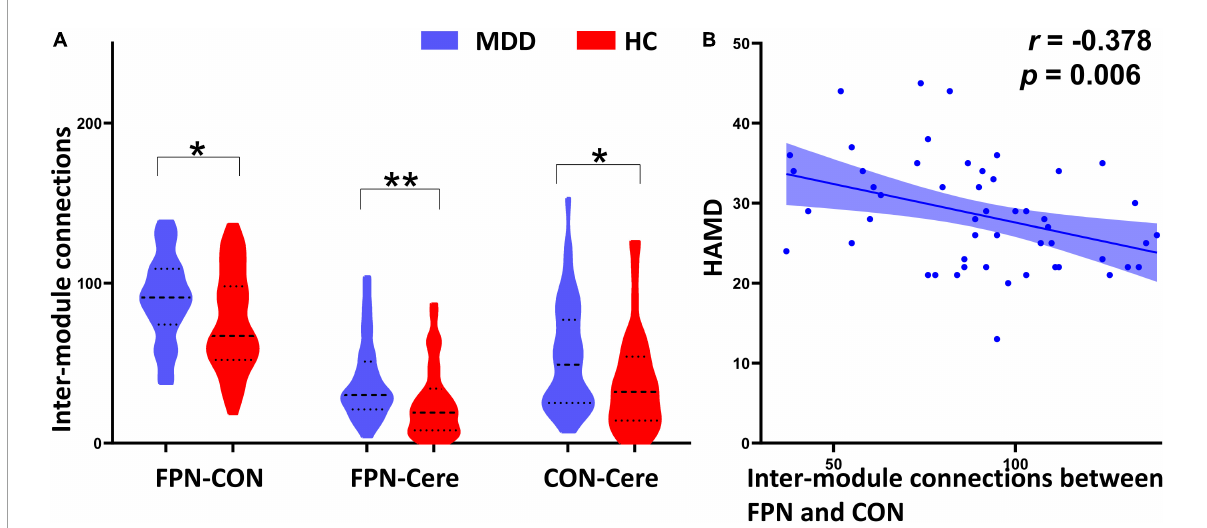
FIGURE3 Between-group comparison of inter-module connections and their correlation with HAMD scores. (A) Compared with the healthy controls (HC), the major depressive disorder (MDD) patients exhibited significantly increased inter-module connections between the frontal–parietal network (FPN) and cingulo-opercular network (CON), FPN and cerebellum (Cere), CON and Cere. (B) The inter-module connections between the FPN and CON are significantly negatively correlated with HAMD scores in the MDD group. *Indicates p < 0.05, **indicates p < 0.01.